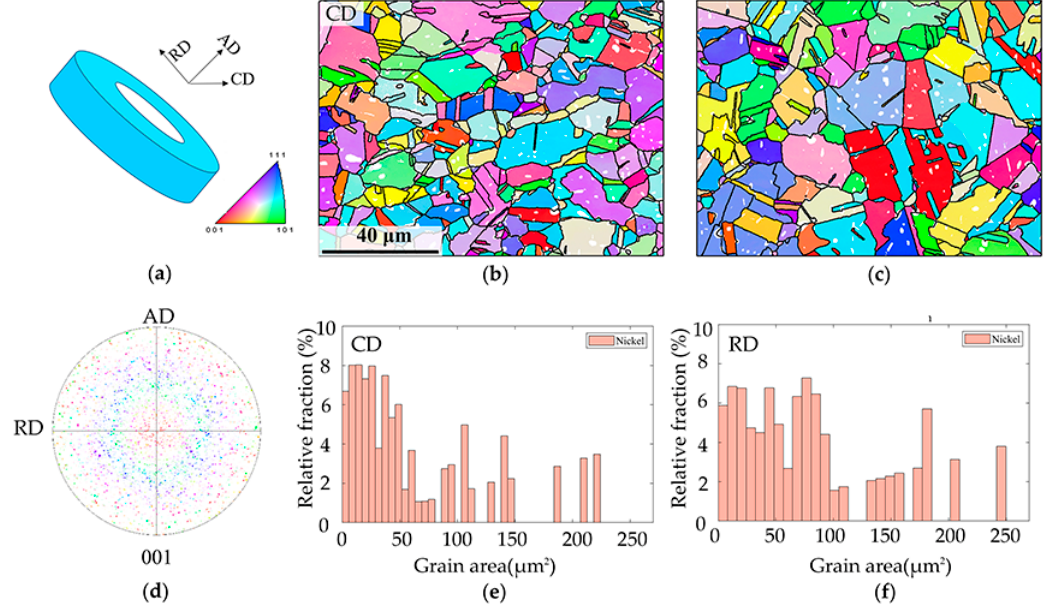
Figure 2. ( a ) Sample orientation. ( b ) EBSD mapping along CD. ( c ) EBSD mapping along RD. ( d ) Pole figure of CD. ( e ) Grain size distribution of CD. ( f ) Grain size distribution of RD.